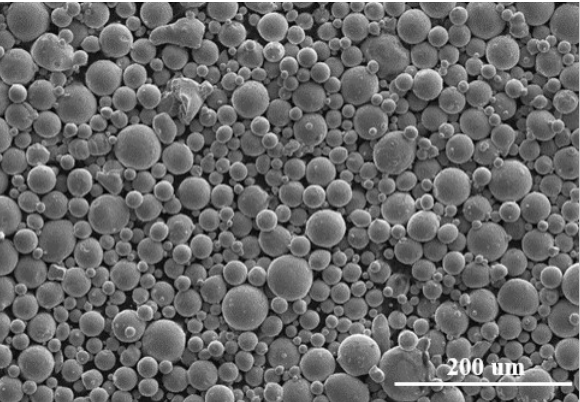
Figure 7. Morphology of Ti6Al4V powder material. Table 3. Process parameters of L-PBF